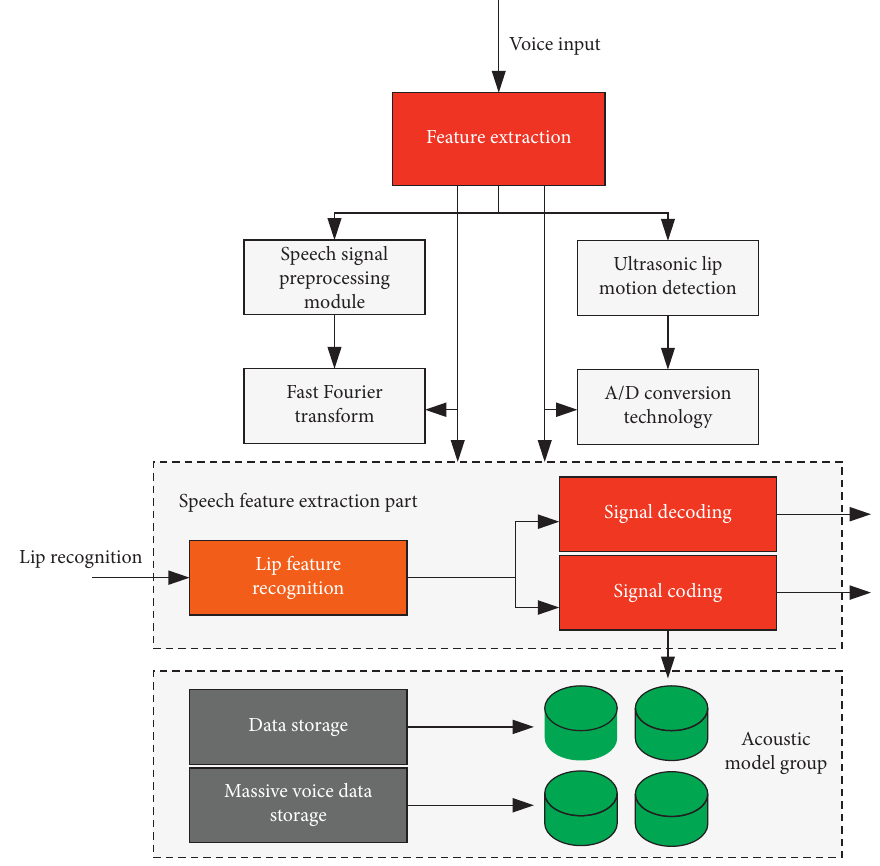
Figure 2: Schematic diagram of speech recognition technology for oral English pronunciation